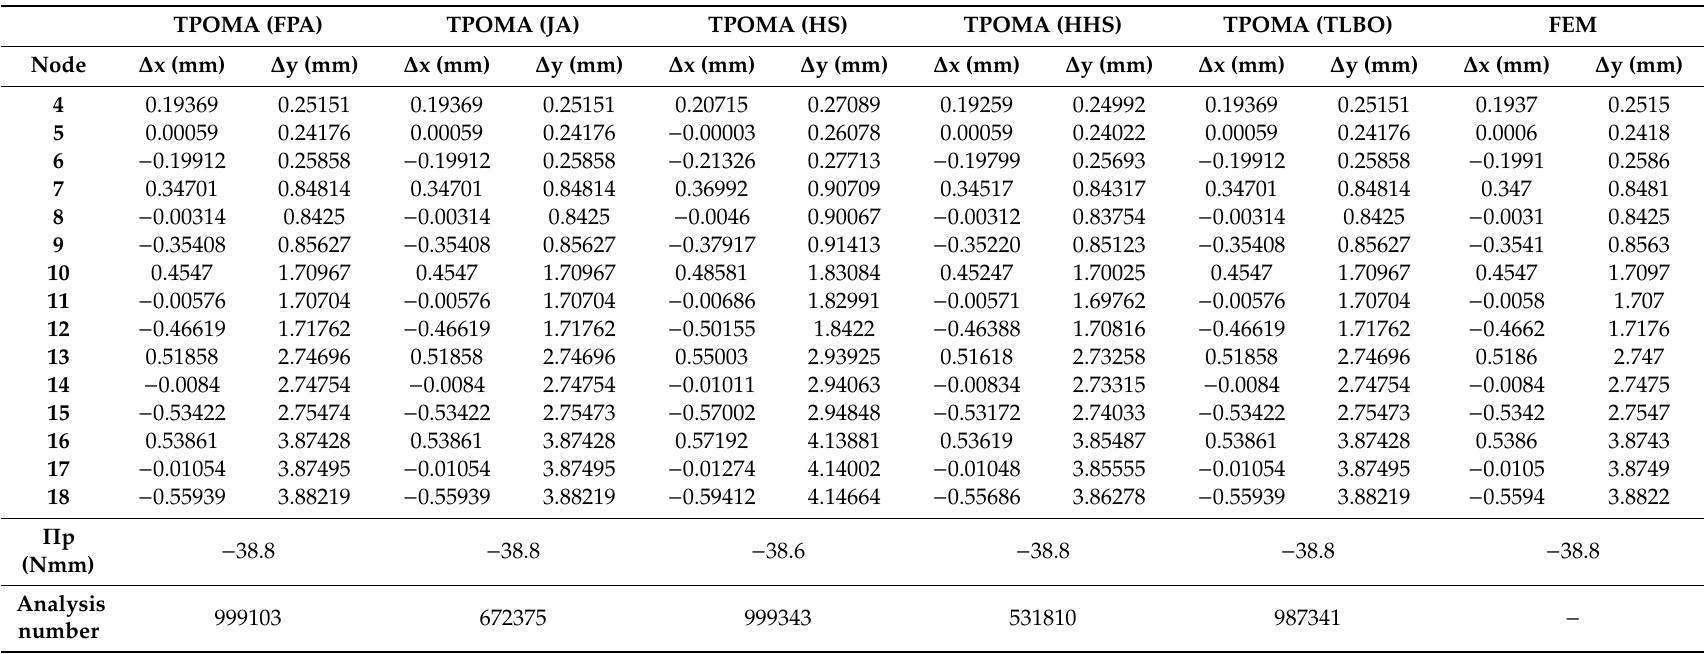
Table 1. Solutions for the cantilever beam with 20 plane